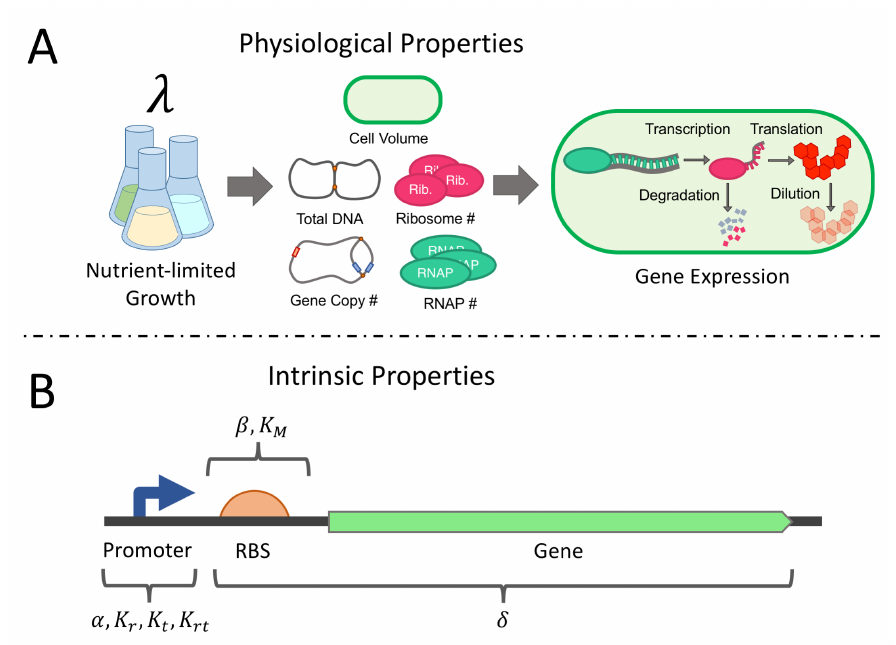
Figure 1. ( A ) Growth media nutrient quality dictates the growth rate of an E. coli culture. The observed growth rate can be used to predict many physiological parameters of the host, which in turn influence gene expression. ( B ) By accounting for physiological parameters, we can optimally estimate